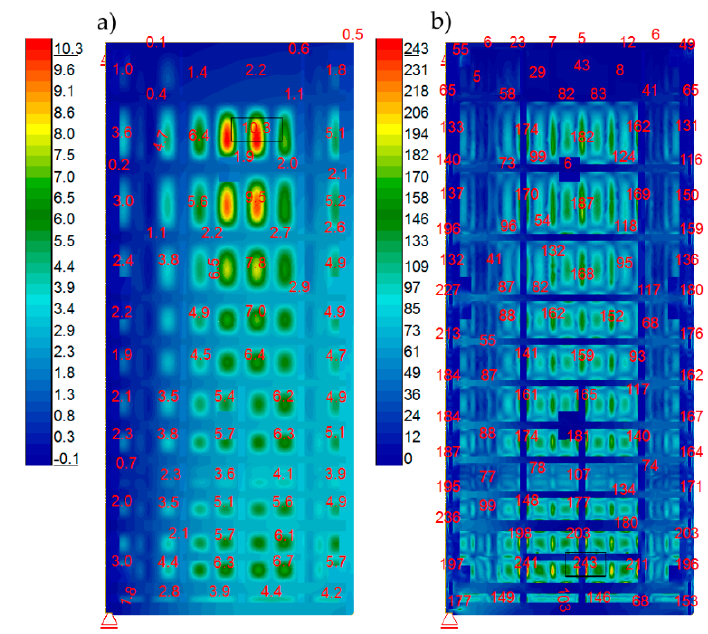
Figure 16. Calculation results regarding load A. ( a ) Displacements [mm] at water thrust direction; ( b ) Maximum von Mises stresses [MPa].